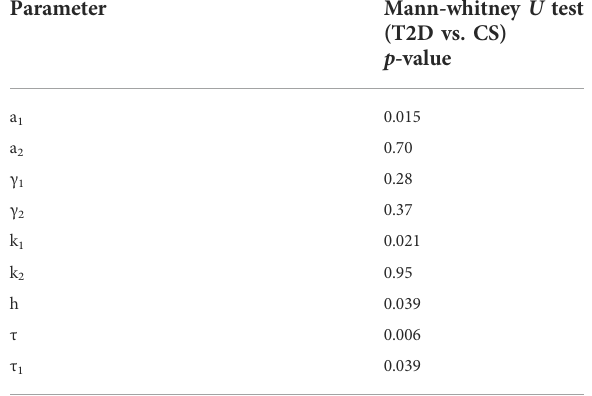
TABLE 6Parameters determinedfrom fi tting thehysteresisModel2to datafrompatientswithT2D.Theparametersa 1 -k 2 arecomparable to that for Hill Model 1. The value of h 1 is approximately equal to h 2 in all subjects implying there is no hysteresis in diabetic subjects. Only subject eight showed a signi fi cant drop in h 2 compared to h 1 .